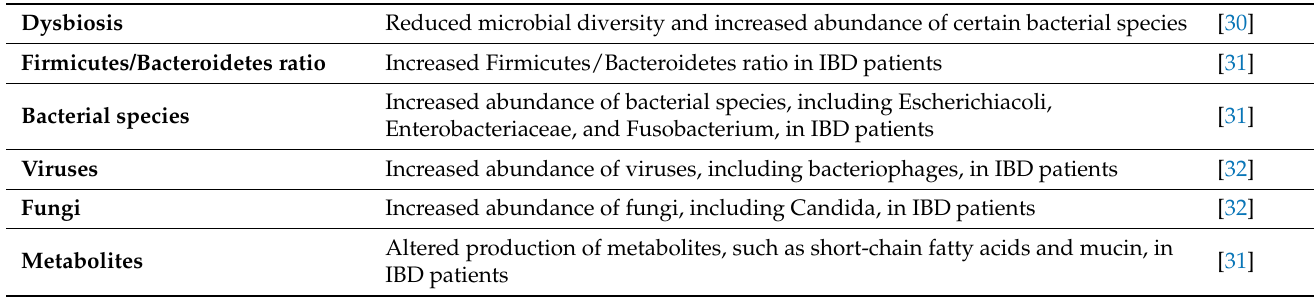
Table 1. The unique and diverse characteristics of the gut microbiota in IBD